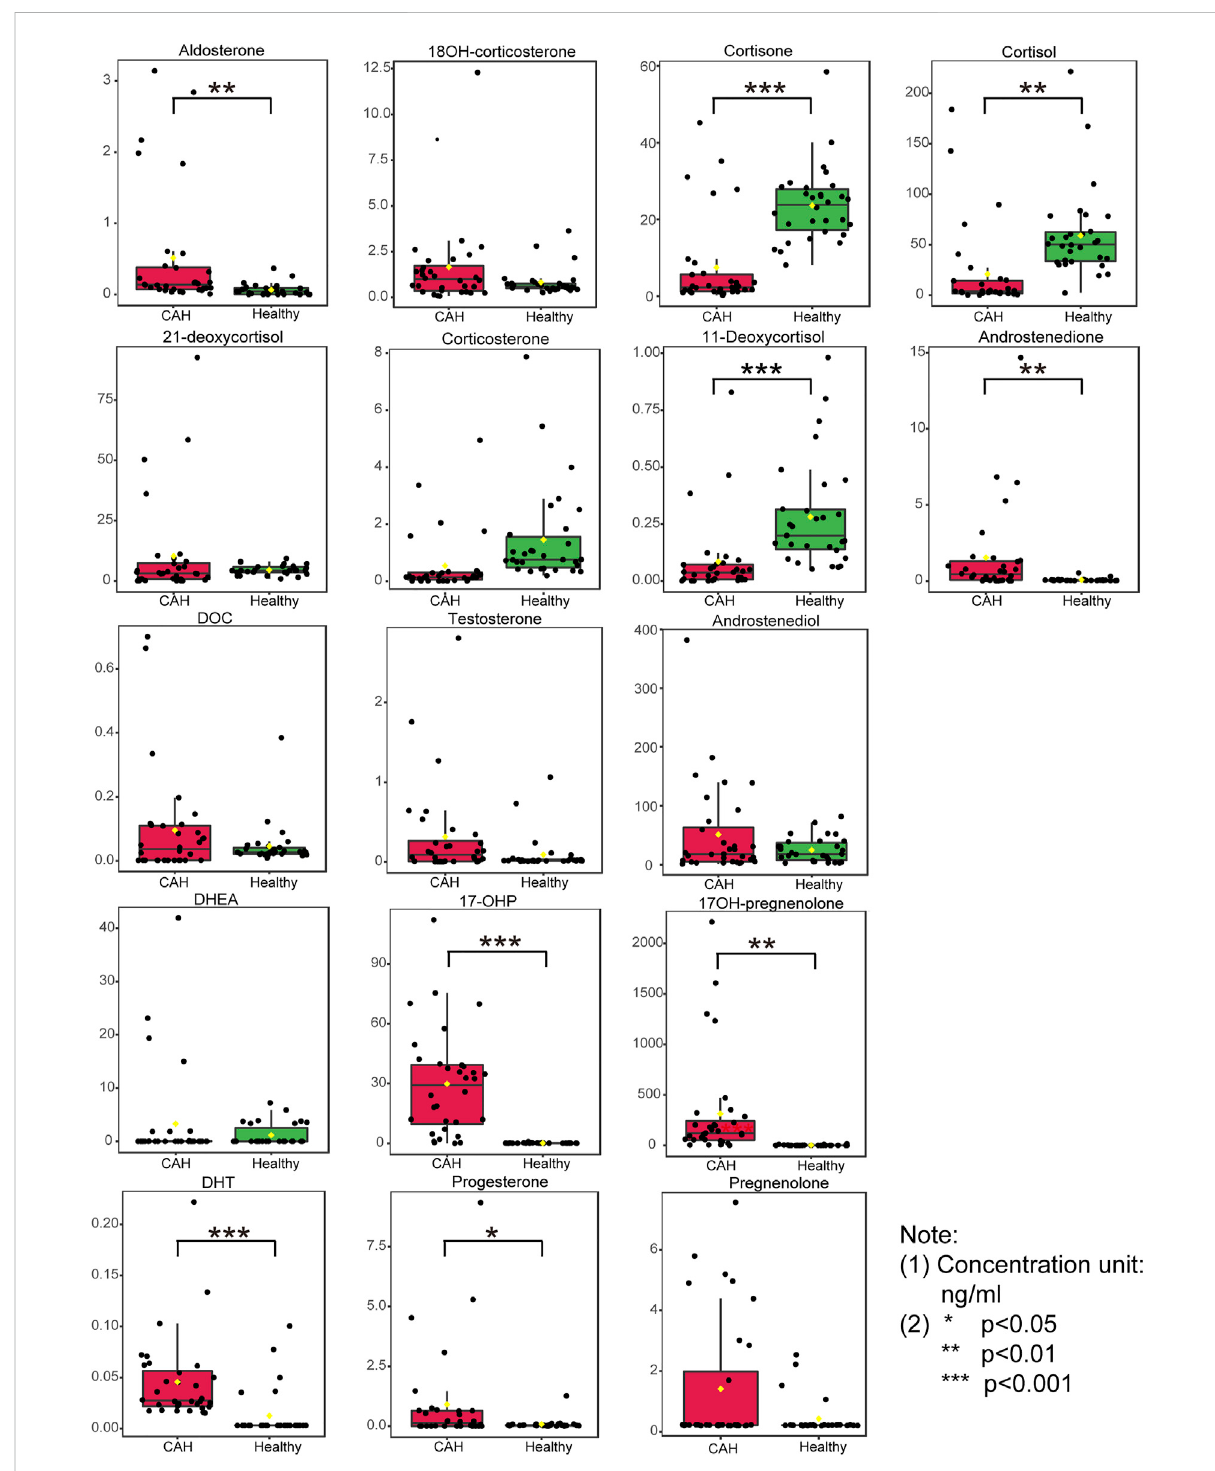
FIGURE 5 Boxplots of the 17 hormones concentration in plasma specimens from 32 congenital adrenal hyperplasia (CAH) patients and 30 healthy volunteers. (* p < 0.05, ** p < 0.01, *** p <